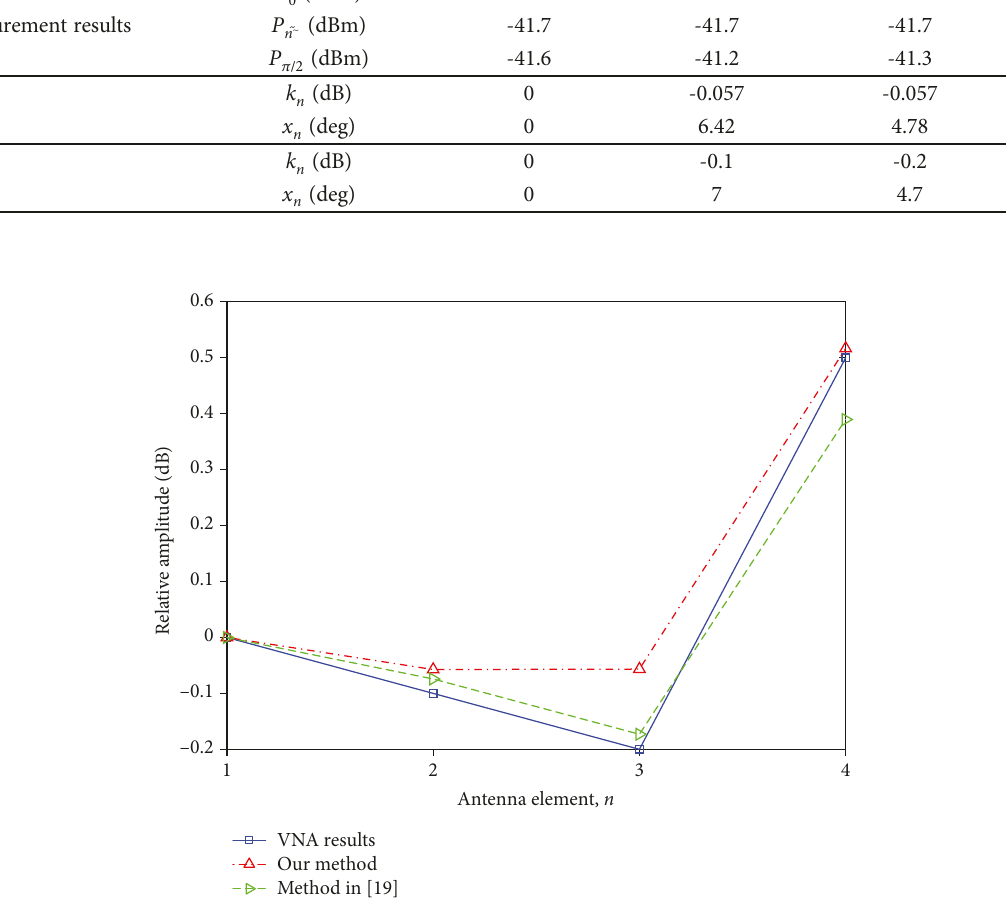
Figure 12: The amplitude calibration results of the four-element patch antenna